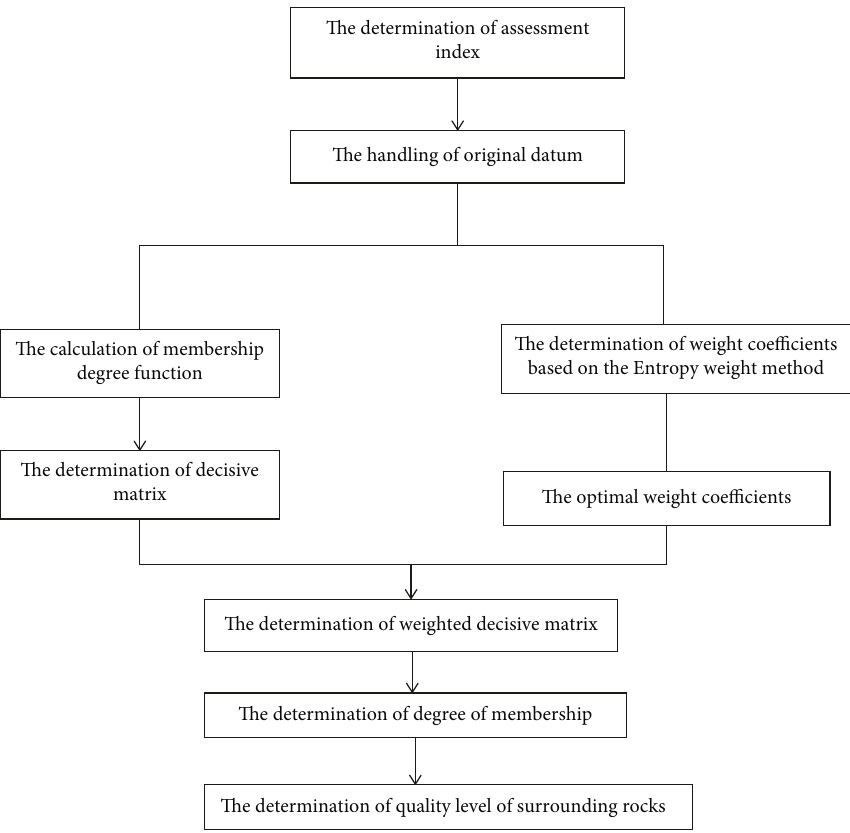
Figure 1: The assessment process of quality of surrounding rocks. Table 2: The quality level of surrounding rocks and assessment